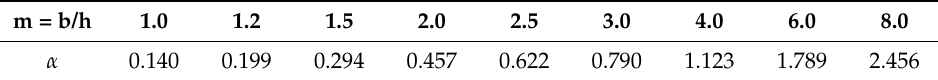
Table 1. Parameter α